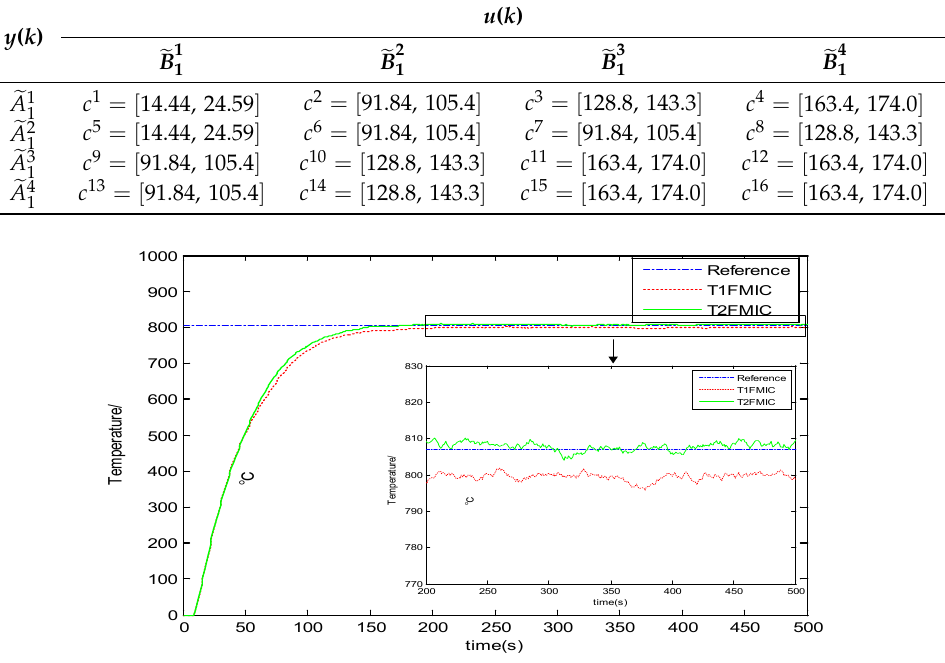
Figure 13. Tracking curve of IT1-FMIC and IT2-FMIC.